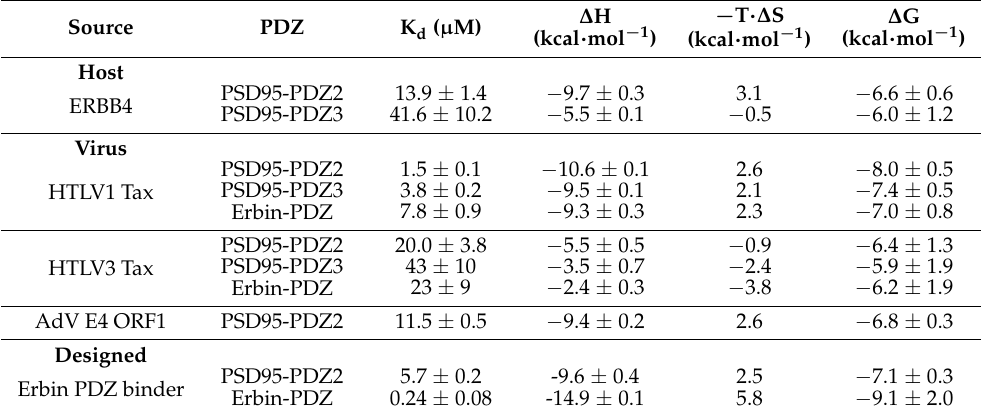
Table 1. Thermodynamic parameters of the interactions between the PDZ domains and ligands that have been determined by ITC 1